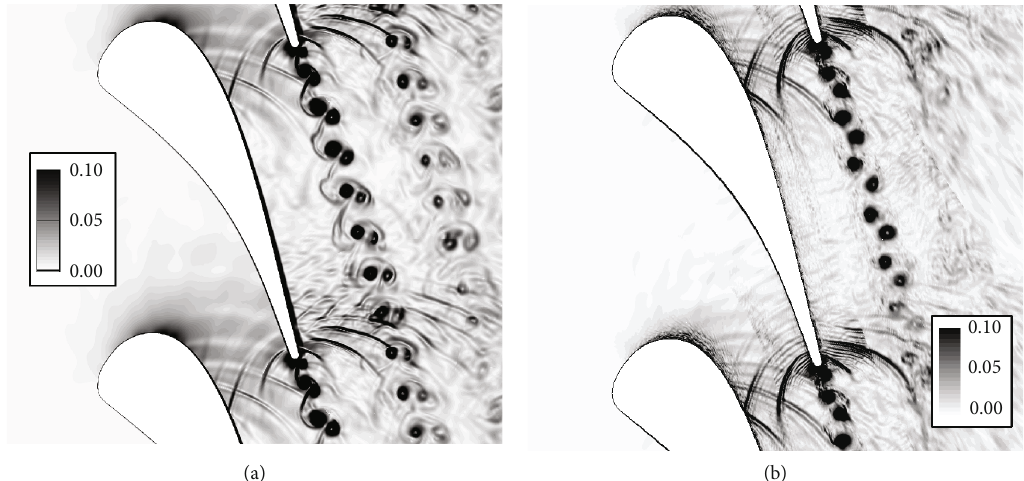
Figure 6: Dimensionless density gradient contours of fl ow condition MUR129: (a) present SAS result; (b) LES result [9].